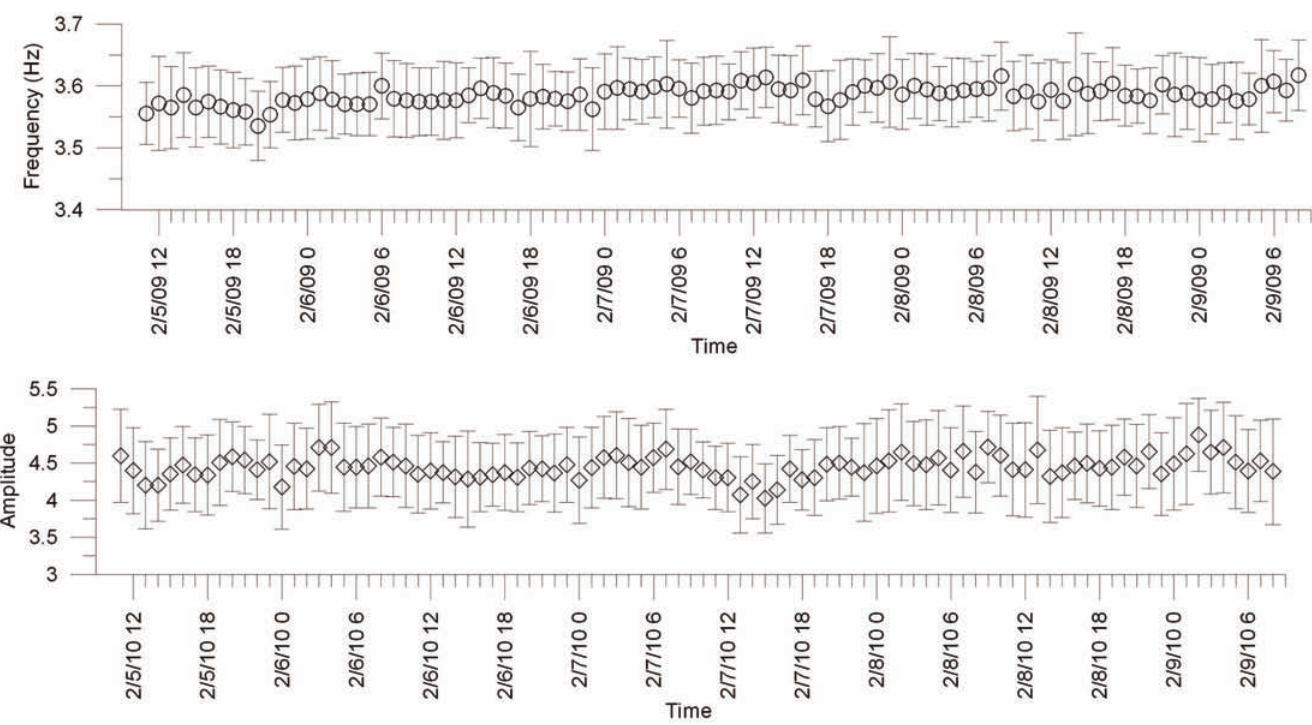
Figure 7. Temporal behaviors of the fundamental frequencies (top) and the corresponding amplitudes (bottom) for station MVR2, with their associated error bars, over 1-h-long time